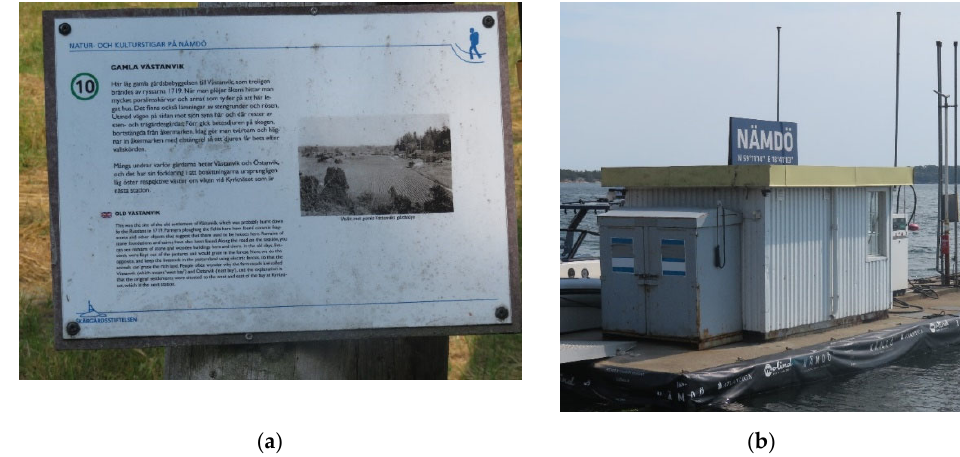
Figure 6. Examples of signs designed for the visitors: ( a ) Bilingual information post of the walking trail in the nature reserve on Nämdö; ( b ) commercial branding of the island at Solvik,